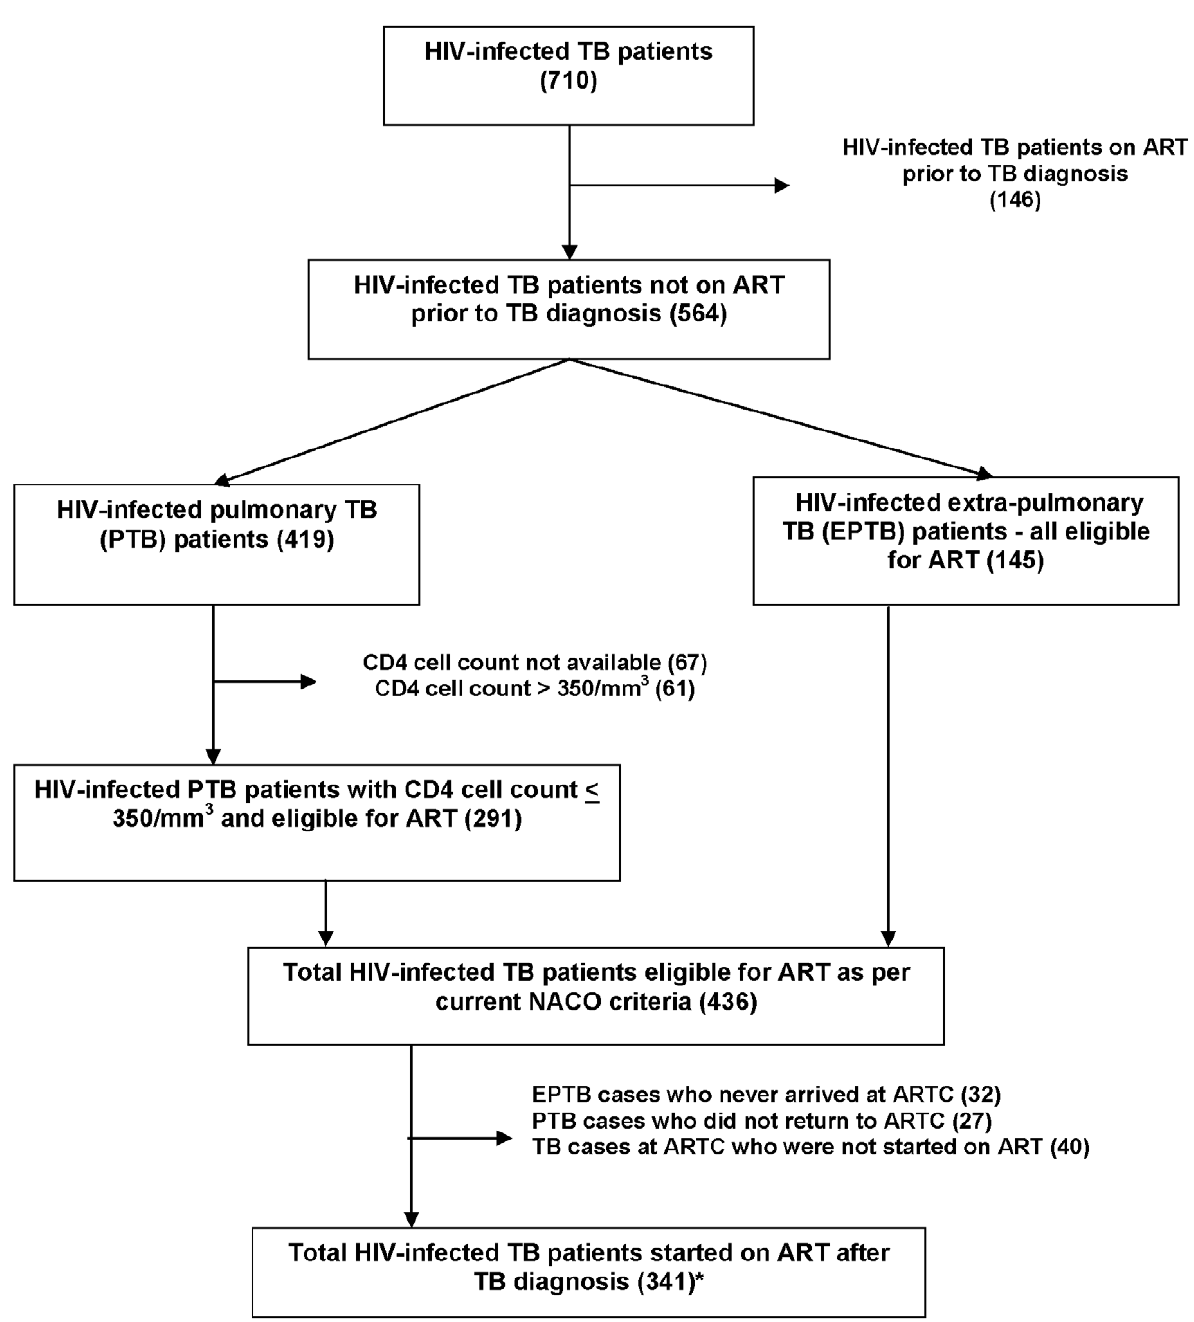
Figure 1. Eligibility for and initiation of antiretroviral treatment in HIV-infected TB patients registered in Karnataka state, India, in June 2010. *4 PTB patients were started on ART even though not eligible as per guidelines TB-Tuberculosis; HIV-Human immunodeficiency virus; PTB-pulmonary tuberculosis; EPTB-extrapulmonary tuberculosis; NACO-National AIDS Control Organization; ART-antiretroviral treatment; ARTC-ART centre.